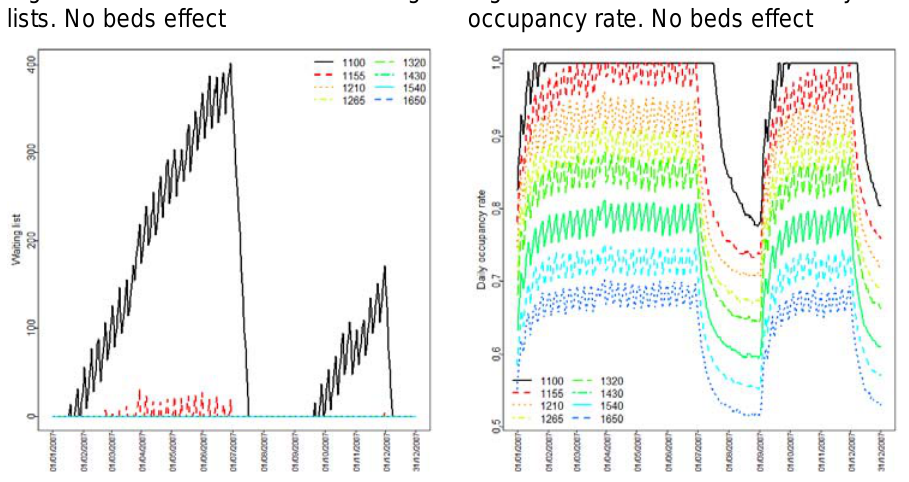
Figure 7. Median of simulated